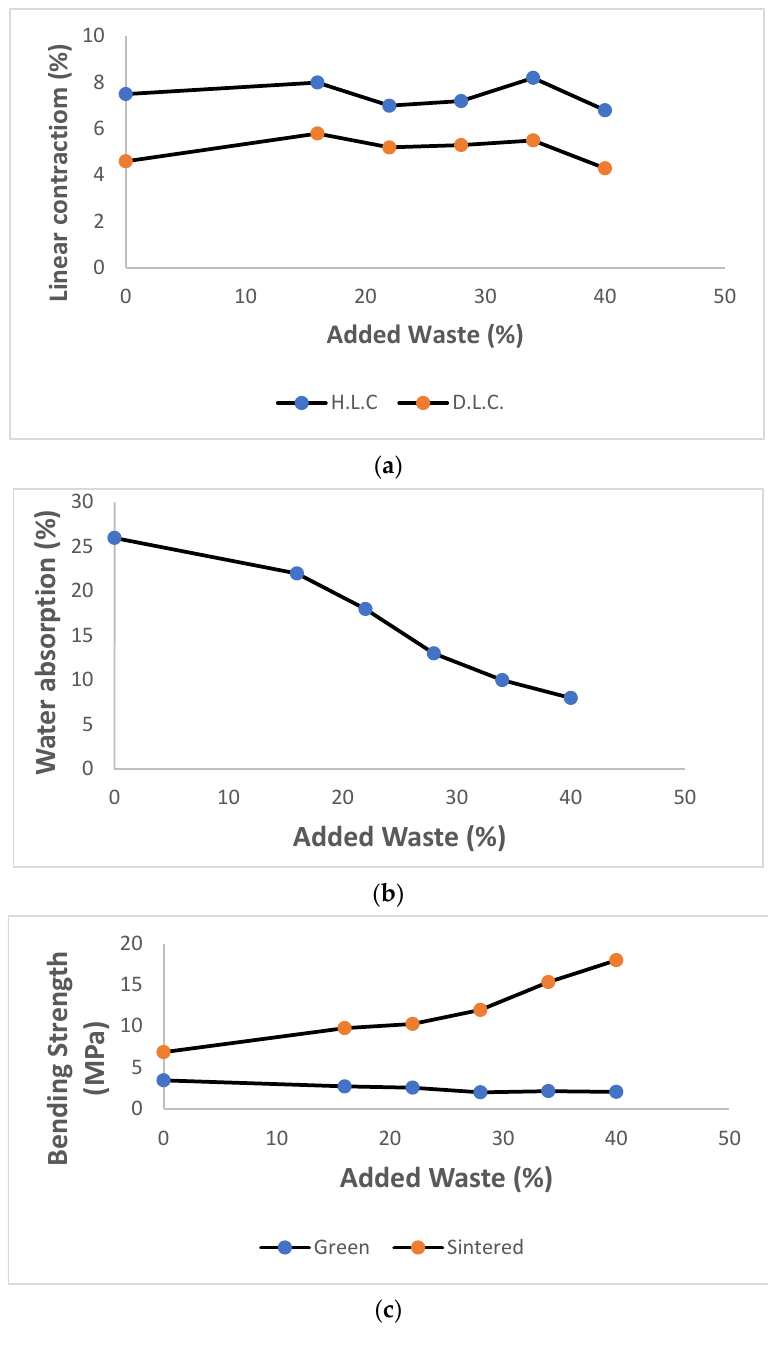
Figure 2. Technological properties for ( a ) LC at 1050 °C (%), ( b ) WA (%) at 1050 °C and ( c ) bend- ing/flexural strength at 1050 °C. Legend: Green—unfired tiles; Sintered—fired tiles.